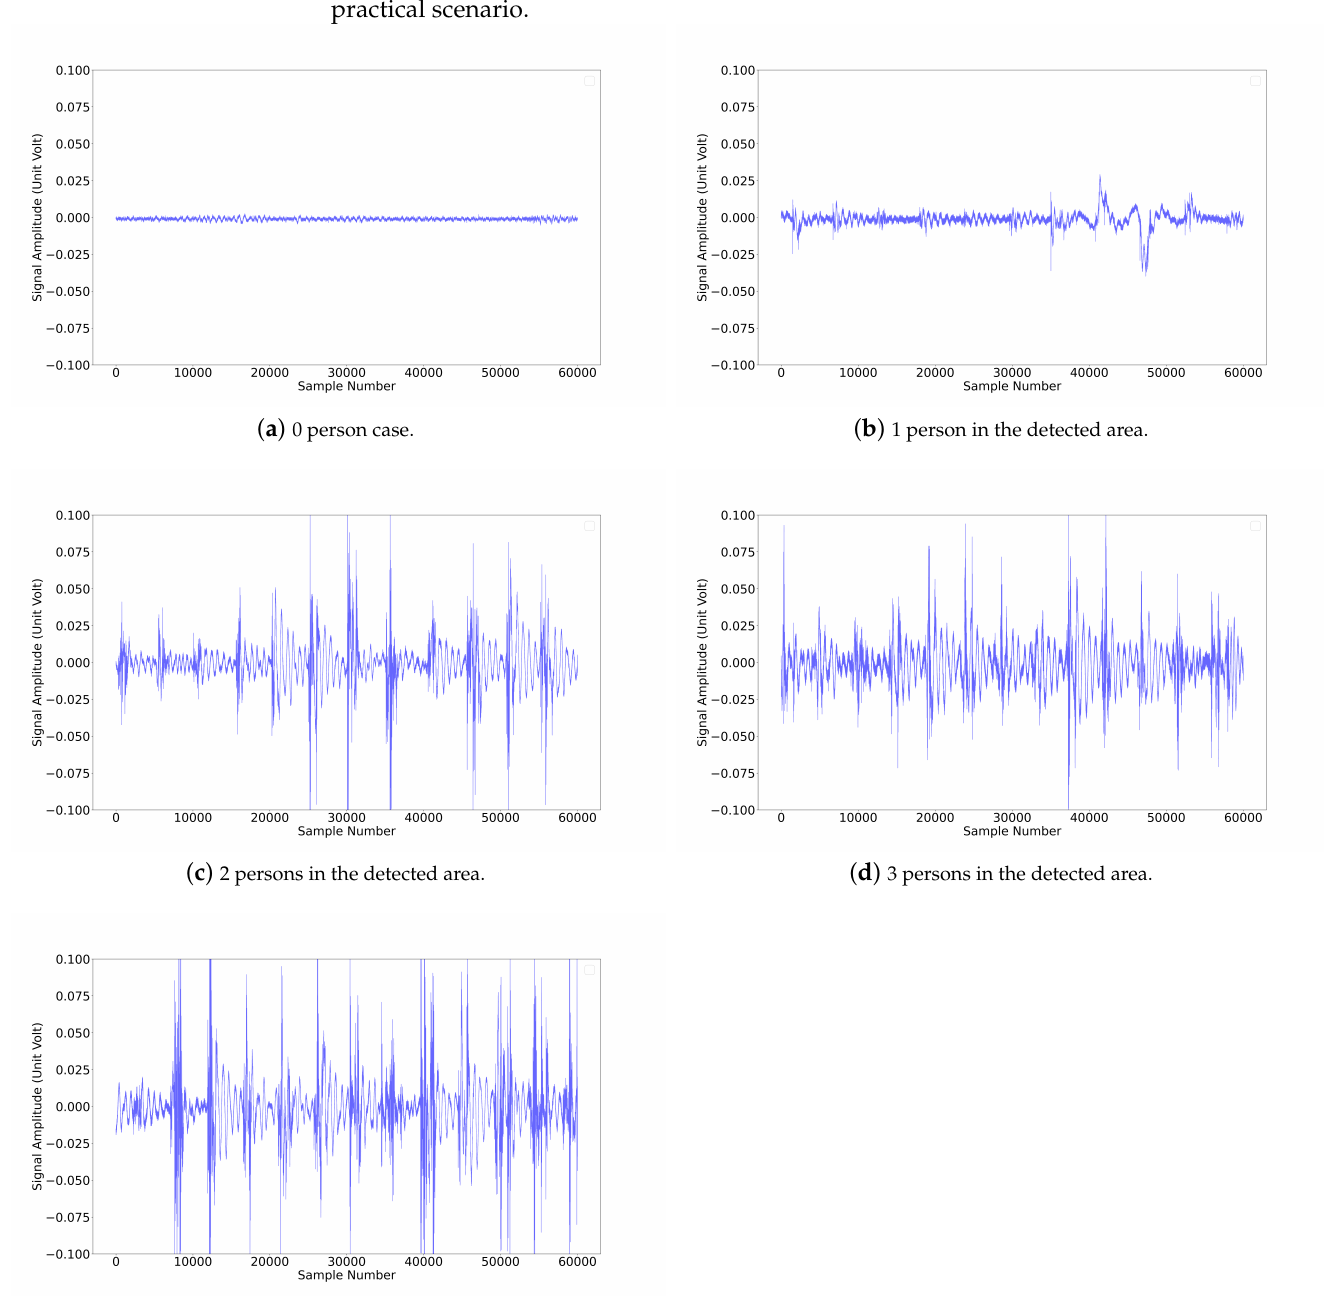
Figure 2. ( a – e ) present the vibration signal in the time domain. The figures show samples of time-specific signal fragments from one of the